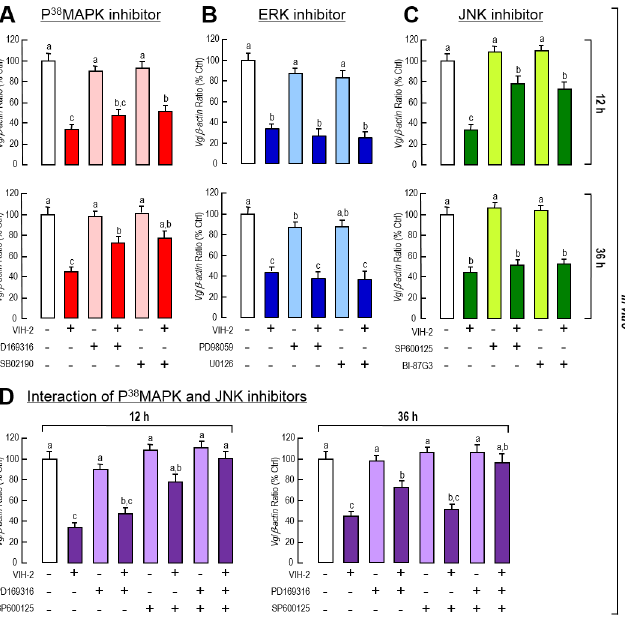
Fig 6. Involvement of MAPK-dependent signaling in VIH-2 suppressed Vg mRNA expression in the hepatopancreas of L . vannamei . A-C: Effects of the P 38 MAPK inhibitor (A), the ERK inhibitor (B) or the JNK inhibitor (C) on VIH-2-inhibited Vg mRNA expression in shrimp hepatopancreatic cell cultures. The hepatopancreatic cells were incubated for 12 h or 36 h with VIH-2 (1 μ M) in the presence or absence of PD169316 (100 nM), or SB02190 (100 nM), PD98059 (10 μ M) or U0126 (1 μ M), and SP600125 (10 μ M) or BI-87G3 (10 μ M). D: Interaction of the P 38 MAPK inhibitor and the JNK inhibitor on VIH-2 inhibited Vg mRNA expression in shrimp hepatopancreatic cell cultures. The hepatopancreatic cells were incubated for 12 h or 36 h with VIH-2 (1 μ M) in the presence or absence of PD169316 (100 nM) or SP600125 (10 μ M) alone, or PD169316 (100 nM) and SP600125 (10 μ M) together. In this study, the data presented are expressed as the mean ± S.E. (n = 4). Experimental groups denoted by the same letter represent a similar level ( P > 0.05,ANOVA followed by Fisher’s LSD test).